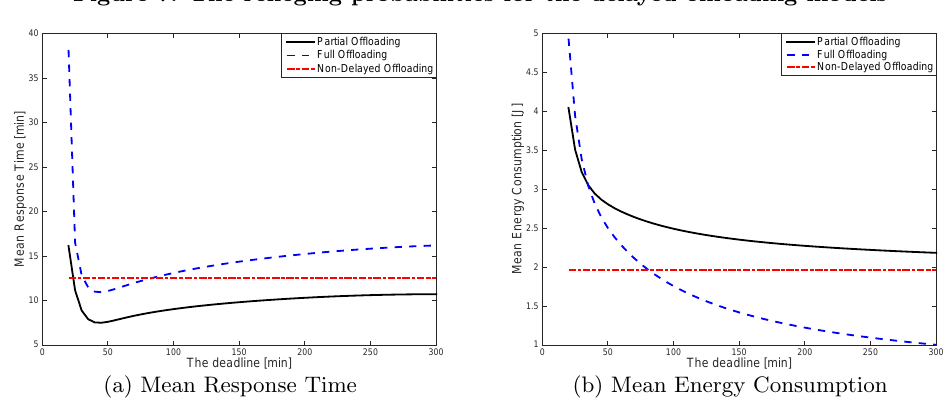
Figure 8: Comparison of the offloading models under different deadlines